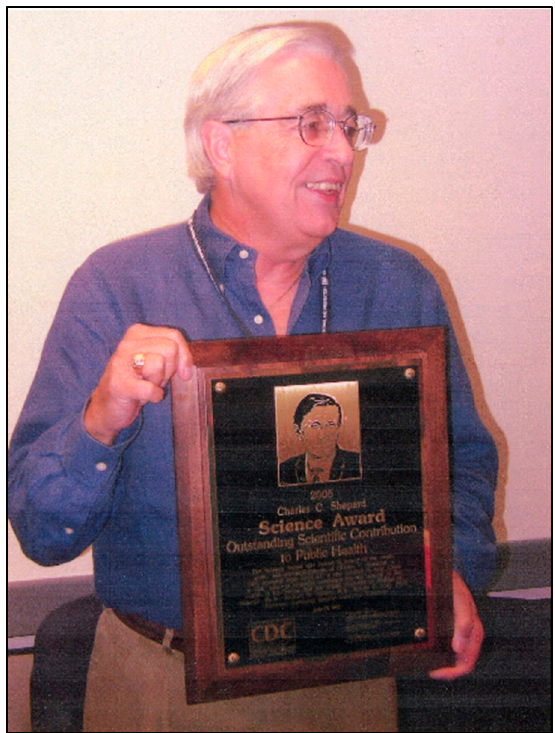
Figure 3. Dr. Hannon with 2005 Shepherd Award. (Photo provided by and approved for use by CDC.).